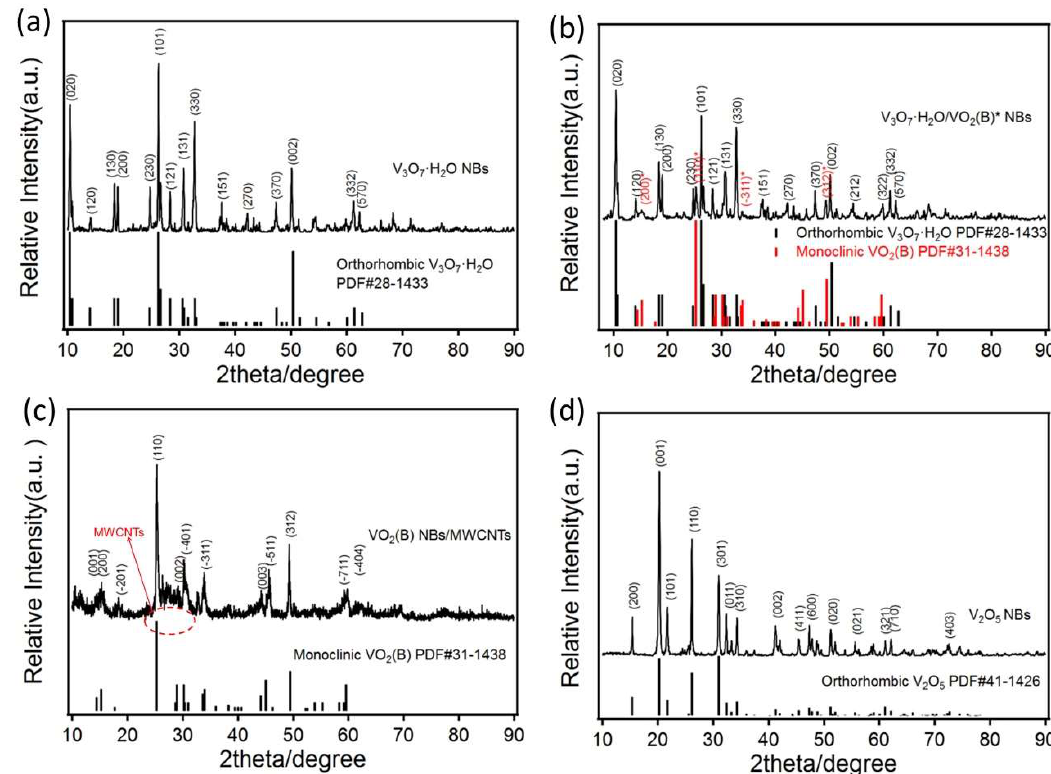
Figure 2. XRD patterns of V 3 O 7 · H 2 O NBs ( a ), V 3 O 7 · H 2 O / VO 2 (B)* NBs ( b ), VO 2 (B) NBs / MWCNTs ( c ) and V 2 O 5 NBs ( d ).